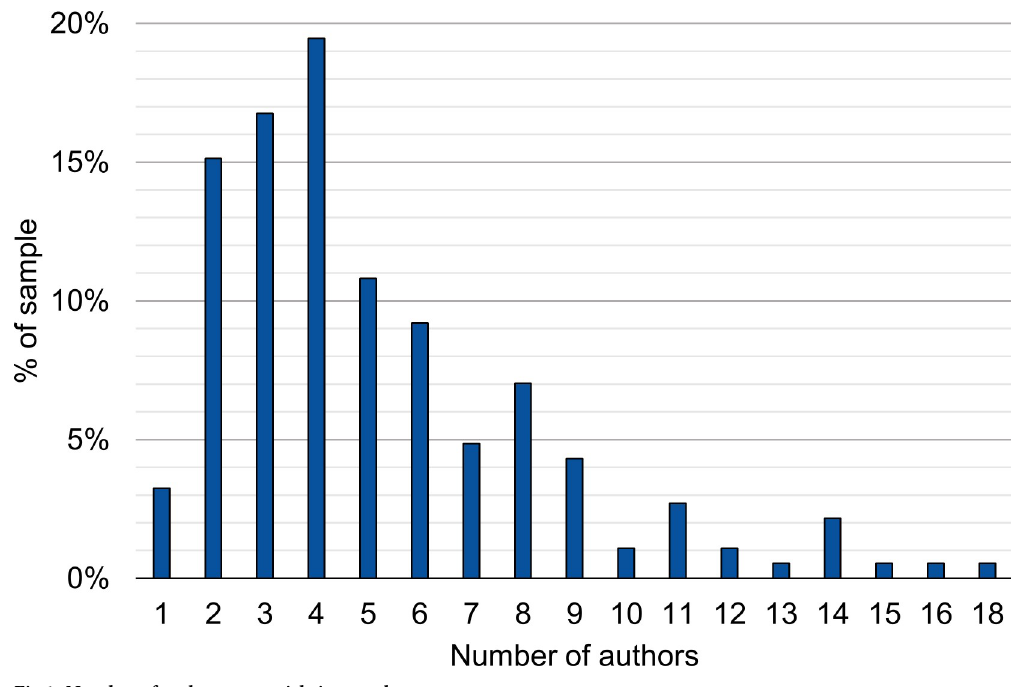
Fig 1. Number of authors per article in